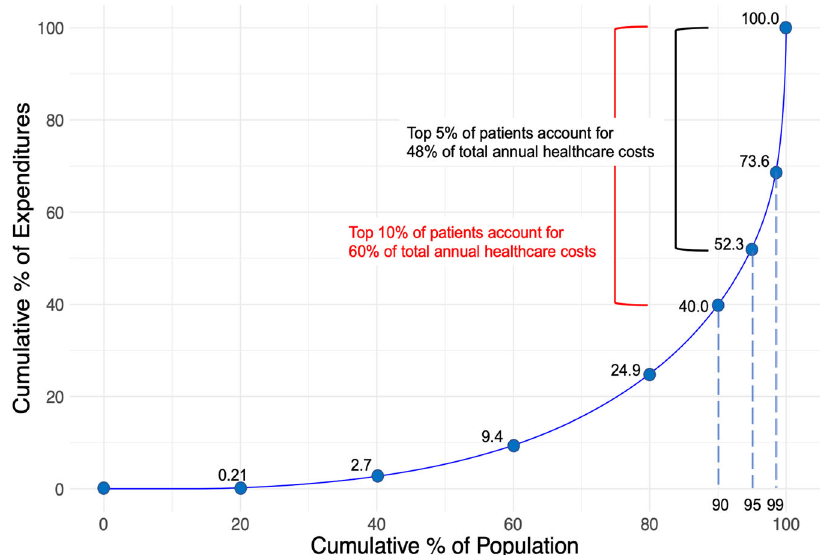
Fig. 1 Distribution of annual healthcare costs in the working-age population in Japan, 2016. In 2016, the top 1%, 5%, 10% of patients accounted for 26.4%, 47.7%, and 60.0% of total annual healthcare costs.